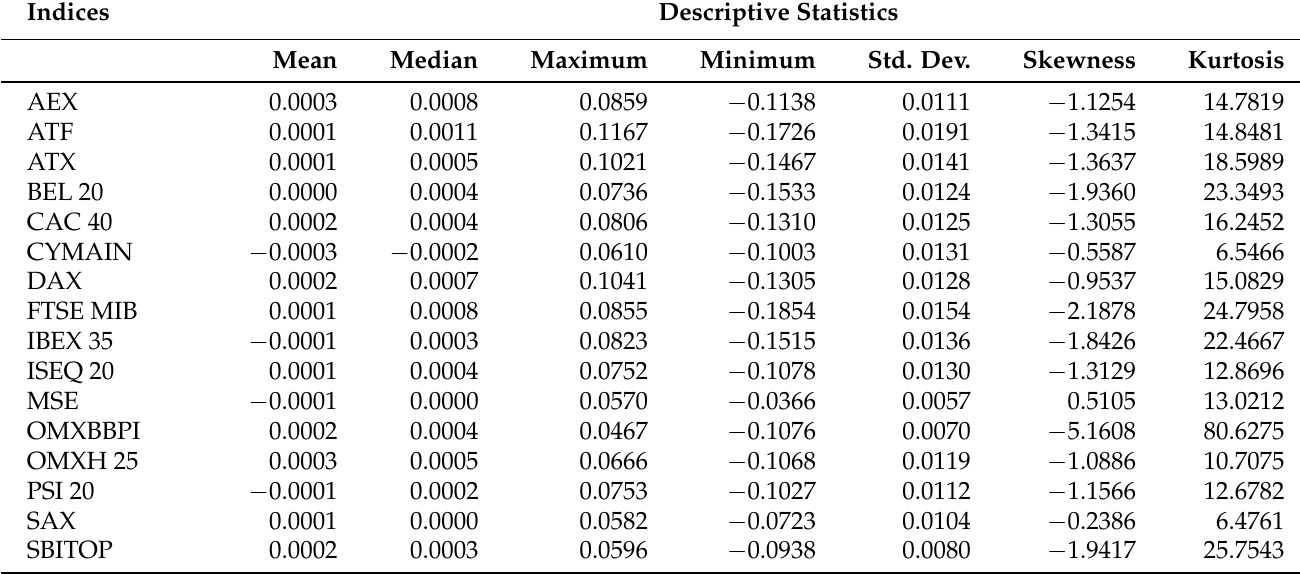
Table A1. Descriptive Statistics Summary.